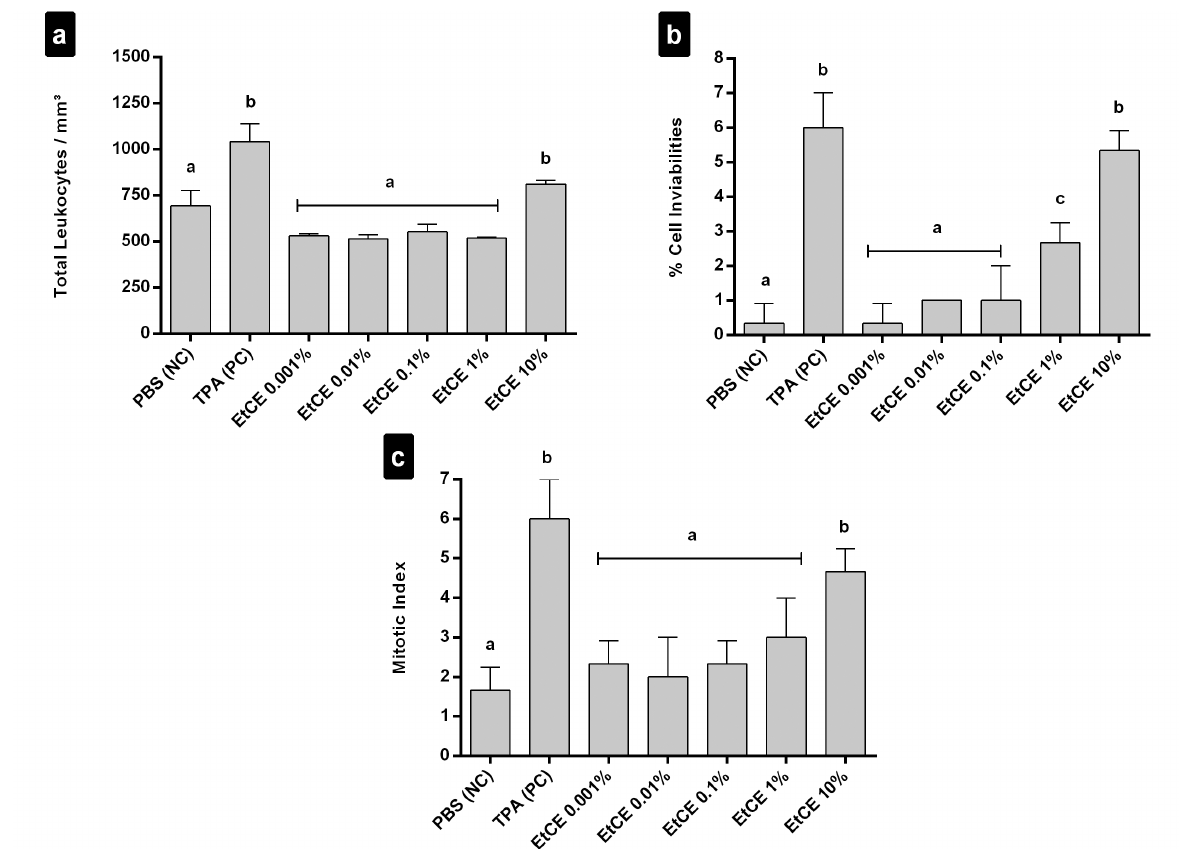
Figure 1 - Markers of cell proliferation. The bar graphs indicate total leukocytes counted (a) , percentage of cell inviability (b) , and mitotic index (c) . PBS: phosphate-buffered saline, TPA: 12-O-tetradecanoylphorbol-13-acetate, EtCE: Euphorbia tirucalli crude extract. Data are presented as mean ± SD (n = 3). Letters indicate statistically signi fi cant